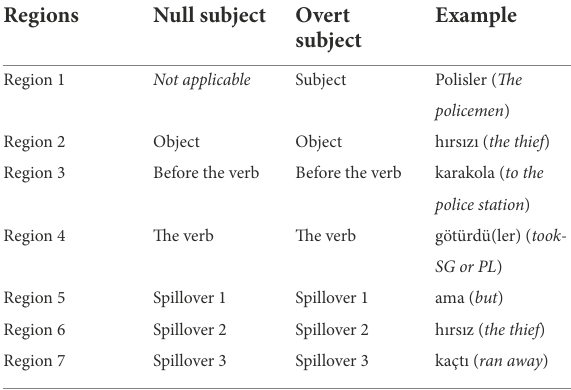
TABLE 1 Regions of interest in the experimental